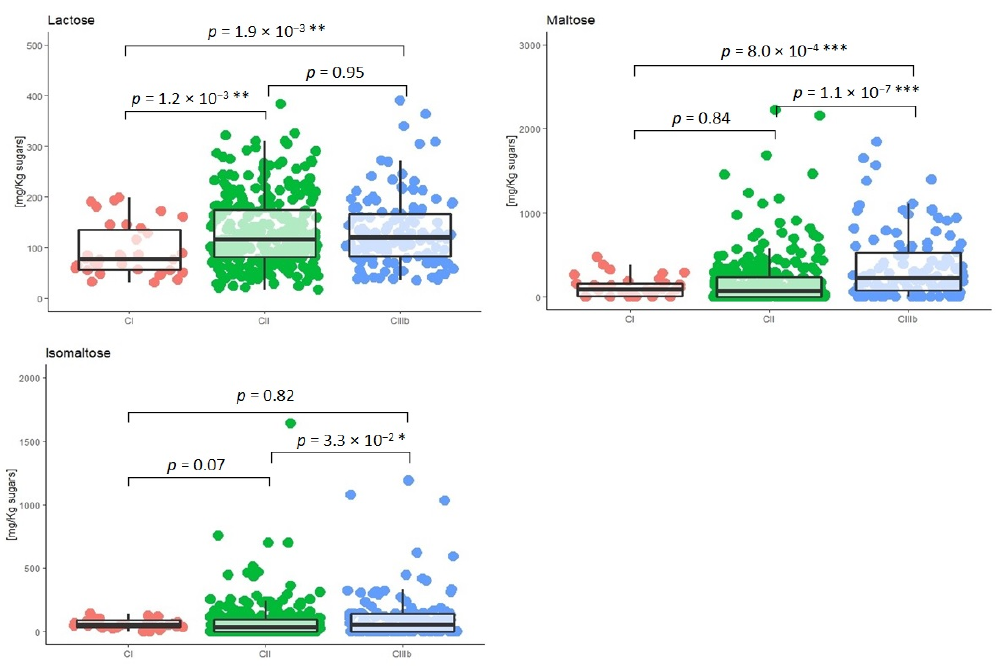
Figure 5. Box plot of the concentration of scyllo -inositol, myo -inositol, sorbitol, sucrose, lactose, maltose, and isomaltose measured in the three Italian wine-growing regions ( • CI: n = 34, • CII: n = 290, and • CIIIb: n = 126). Significance level: * p ≤ 0.05 significant; ** p ≤ 0.01 very significant; *** p ≤ 0.001 highly significant.